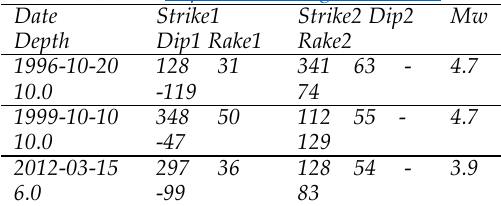
Table 1C. Parameters (strike, dip, and rake of the first and second nodal planes) of TDMT available [Scog- namiglio et al., 2009 - http://cnt.rm.ingv.it/tdmt ] :